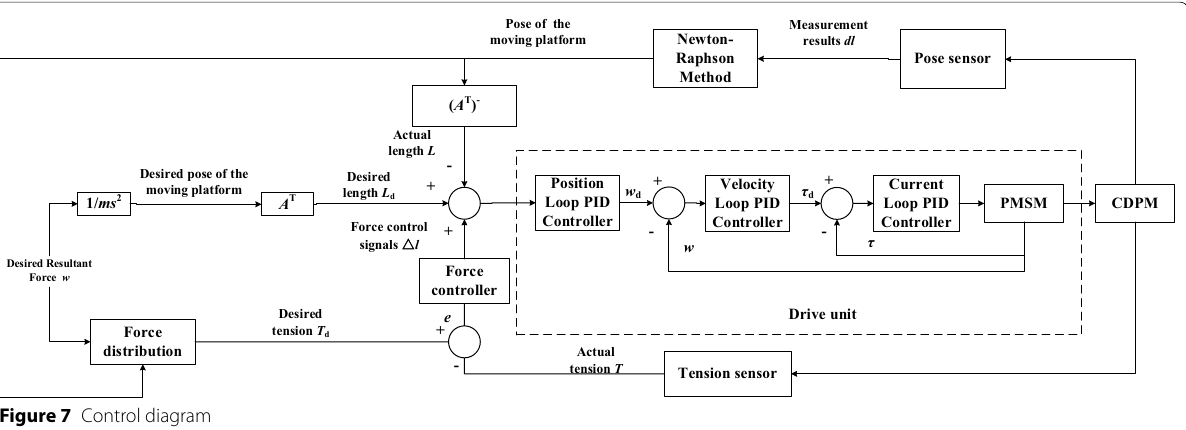
Figure 7 Control diagram